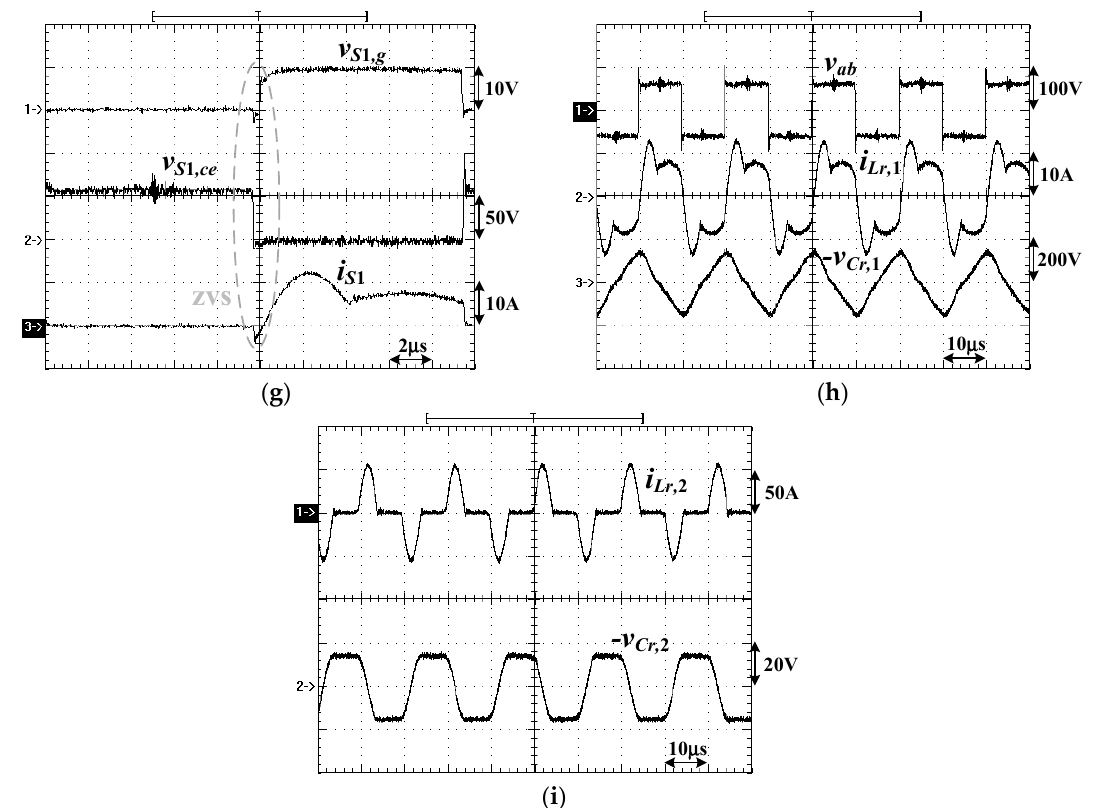
Figure 8. Measured results of the proposed converter under V in = 60 V: ( a ) load current, load voltage, and input voltage under a constant current or constant voltage control; ( b ) the gate voltages of S 1 – S 4 under V o = 40 V; ( c ) v S 1, g , v S 1, ce , and i S 1 under V o = 40 V; ( d ) v ab , i Lr, 1 , and – v Cr, 1 under V o = 40 V; ( e ) i Lr, 2 and – v Cr, 2 under V o = 40 V; ( f ) the gate voltages of S 1 – S 4 under V o = 52 V; ( g ) v S 1, g , v S 1, ce , and i S 1 under V o = 52 V; ( h ) v ab , i Lr, 1 ; and – v Cr, 1 under V o = 52 V; ( i ) i Lr, 2 and – v Cr, 2 under V o = 52 V.